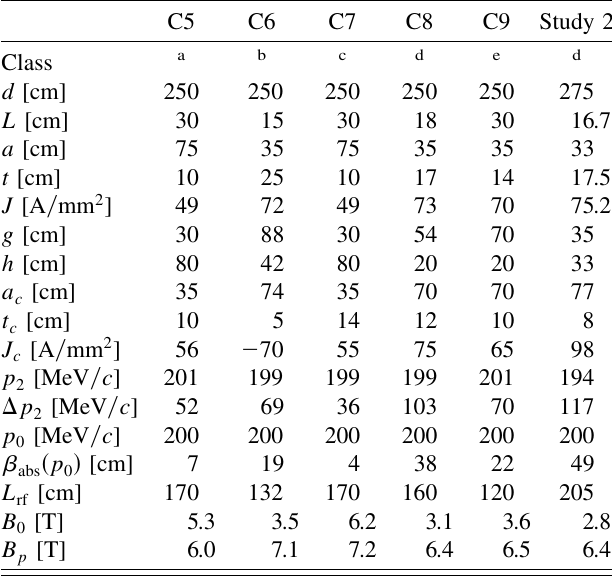
FIG. 17. (Color) The current density J in the focusing coils, the width of the second passband, the beta function at the cell , and the beta function at the cell midplane (cid:4) as boundary (cid:4) b m in the coupling coil. The a function of the current density J c other parameter values were d (cid:2) 2 : 5 m , L (cid:2) 18 cm , a (cid:2) fixed at 200 MeV =c . The coils was adjusted to keep p (cid:2) 70 cm , and 35 cm , t (cid:2) 17 cm , g (cid:2) 54 cm , h (cid:2) 20 cm , a 2 c width of the band tends to grow for increasing coupling (cid:2) 12 cm . t c current. The minimum value of the beta function occurs at the cell boundary for h up to (cid:3) 95 A = mm 2 for this example and then switches to the cell midplane for higher current densities. This shows that the character of the solution can also be changed by varying the relative currents in the coupling and focus coils. TABLE VII. Summary of the three-cell characteristic solu- tions for the second